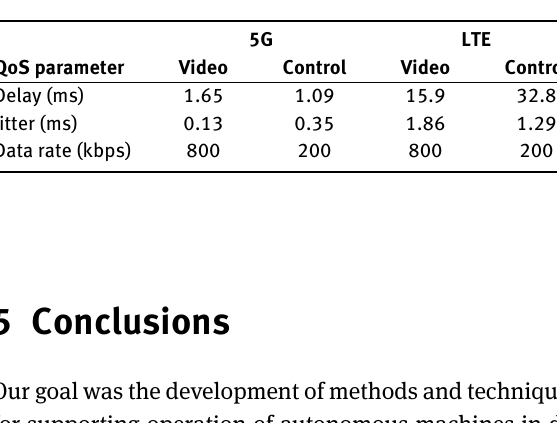
Table 2: Experimental measurements for video and haptics [30]. Delay and jitter are average values over 10